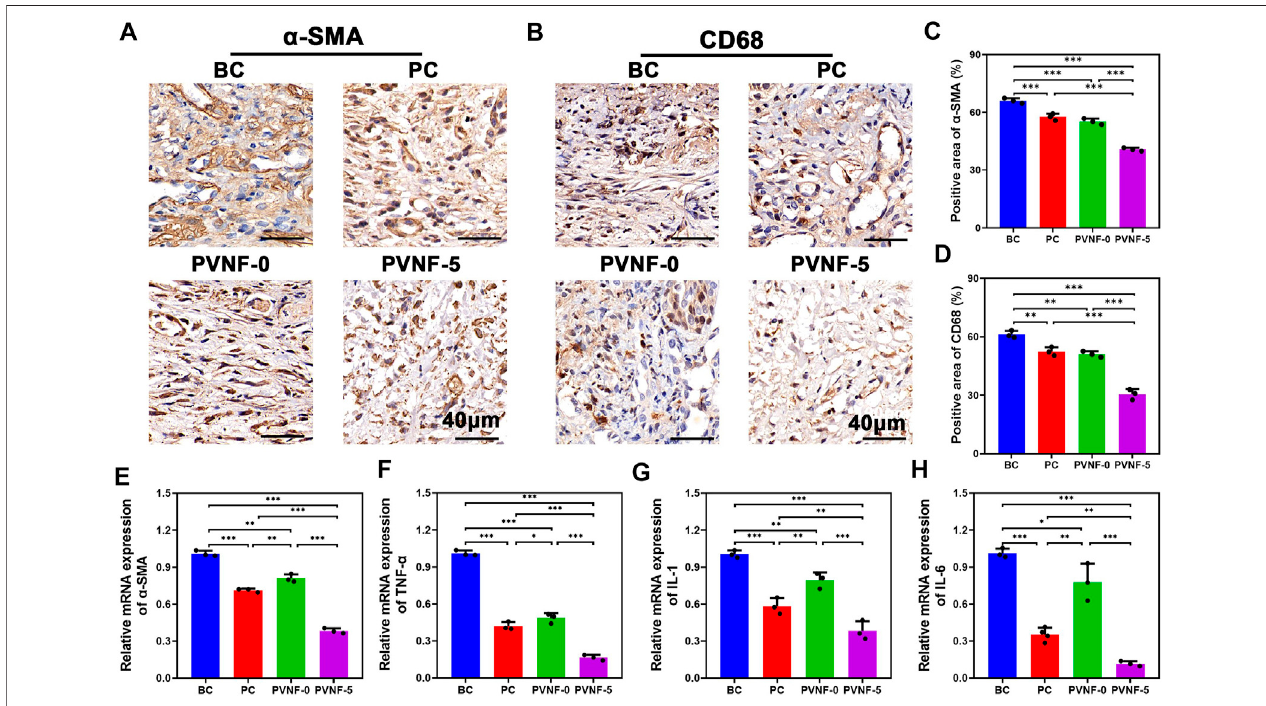
FIGURE 7 | (A, B) α -SMA and CD68 immunohistochemical (IHC) staining in the bare metallic stent (blank control, BC), commercial pellosil matrix – covered stent (PC), PVNF-0 – covered metallic stent, and PVNF-5 – covered metallic stent. (C, D) Quantitative results of the positively stained area of α -SMA and CD68 ( N (cid:1) 3). (E, H) Relative mRNA expression of α -SMA, TNF- α , IL-1, and IL-6, respectively ( N (cid:1) 3). Scale bar: 100 μ m * p < 0.05, ** p < 0.01, and *** p <